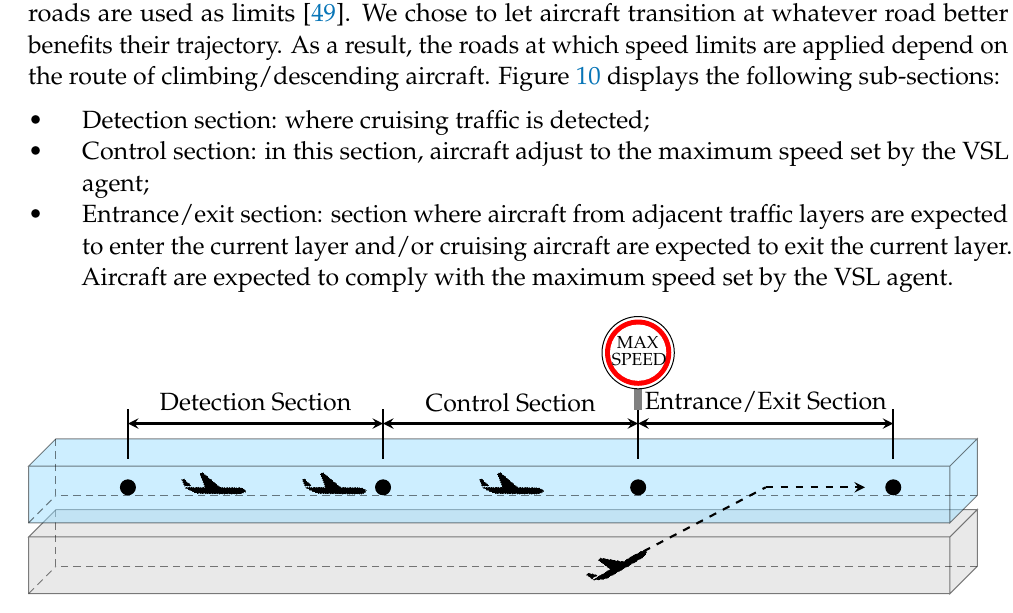
Figure 10. Sub-sections forming a road constructed around the movement of a climbing/descending aircraft. The reinforcement learning agent sets a maximum speed limit for the entrance/exit section.